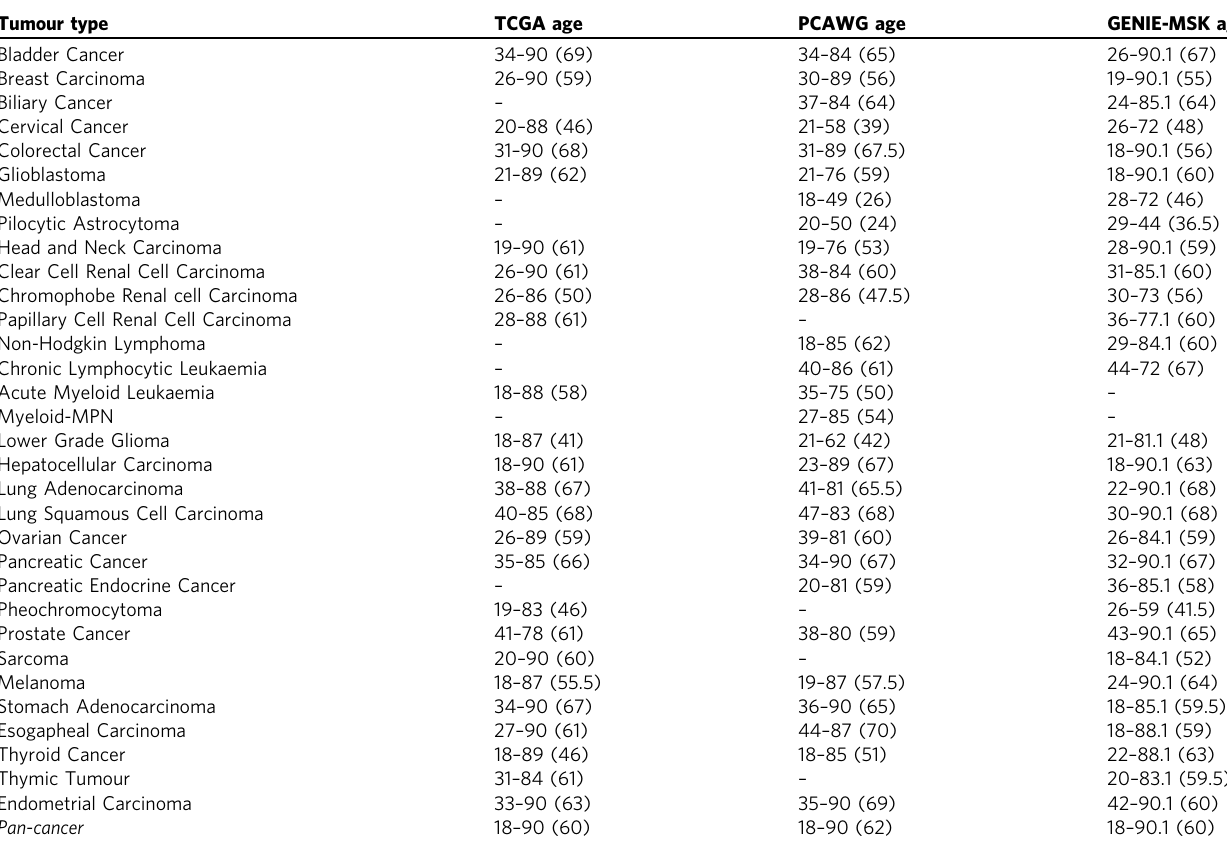
Table 1 Summary of age data per